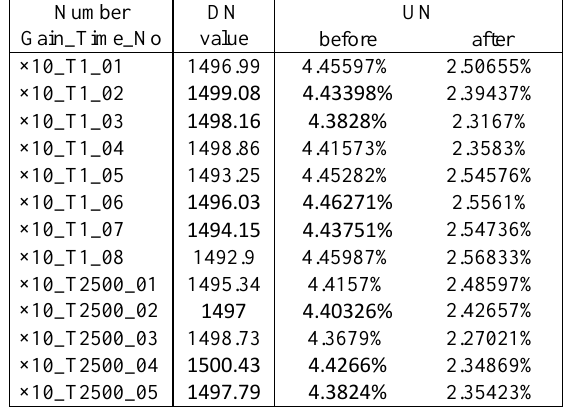
Table 2: Non-uniformity measure of CMOS imaging in the various integrating sphere output radiance conditions